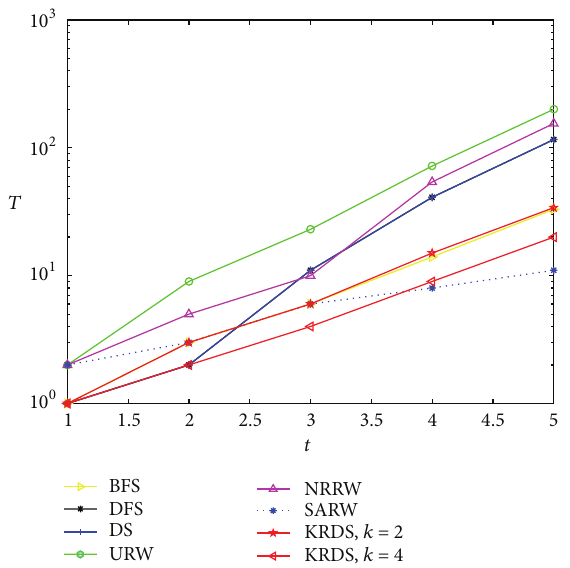
Figure 10: Plot of the average number 𝑇 of search steps versus the number 𝑡 of iterations of the DMG in the semilog scale.